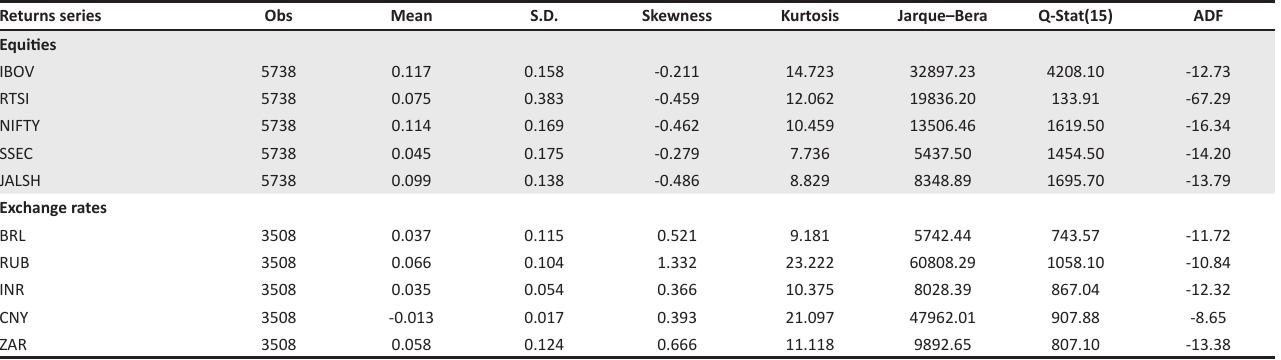
TABLE 2: Summary statistics for returns in equity and foreign exchange markets. Returns series Obs